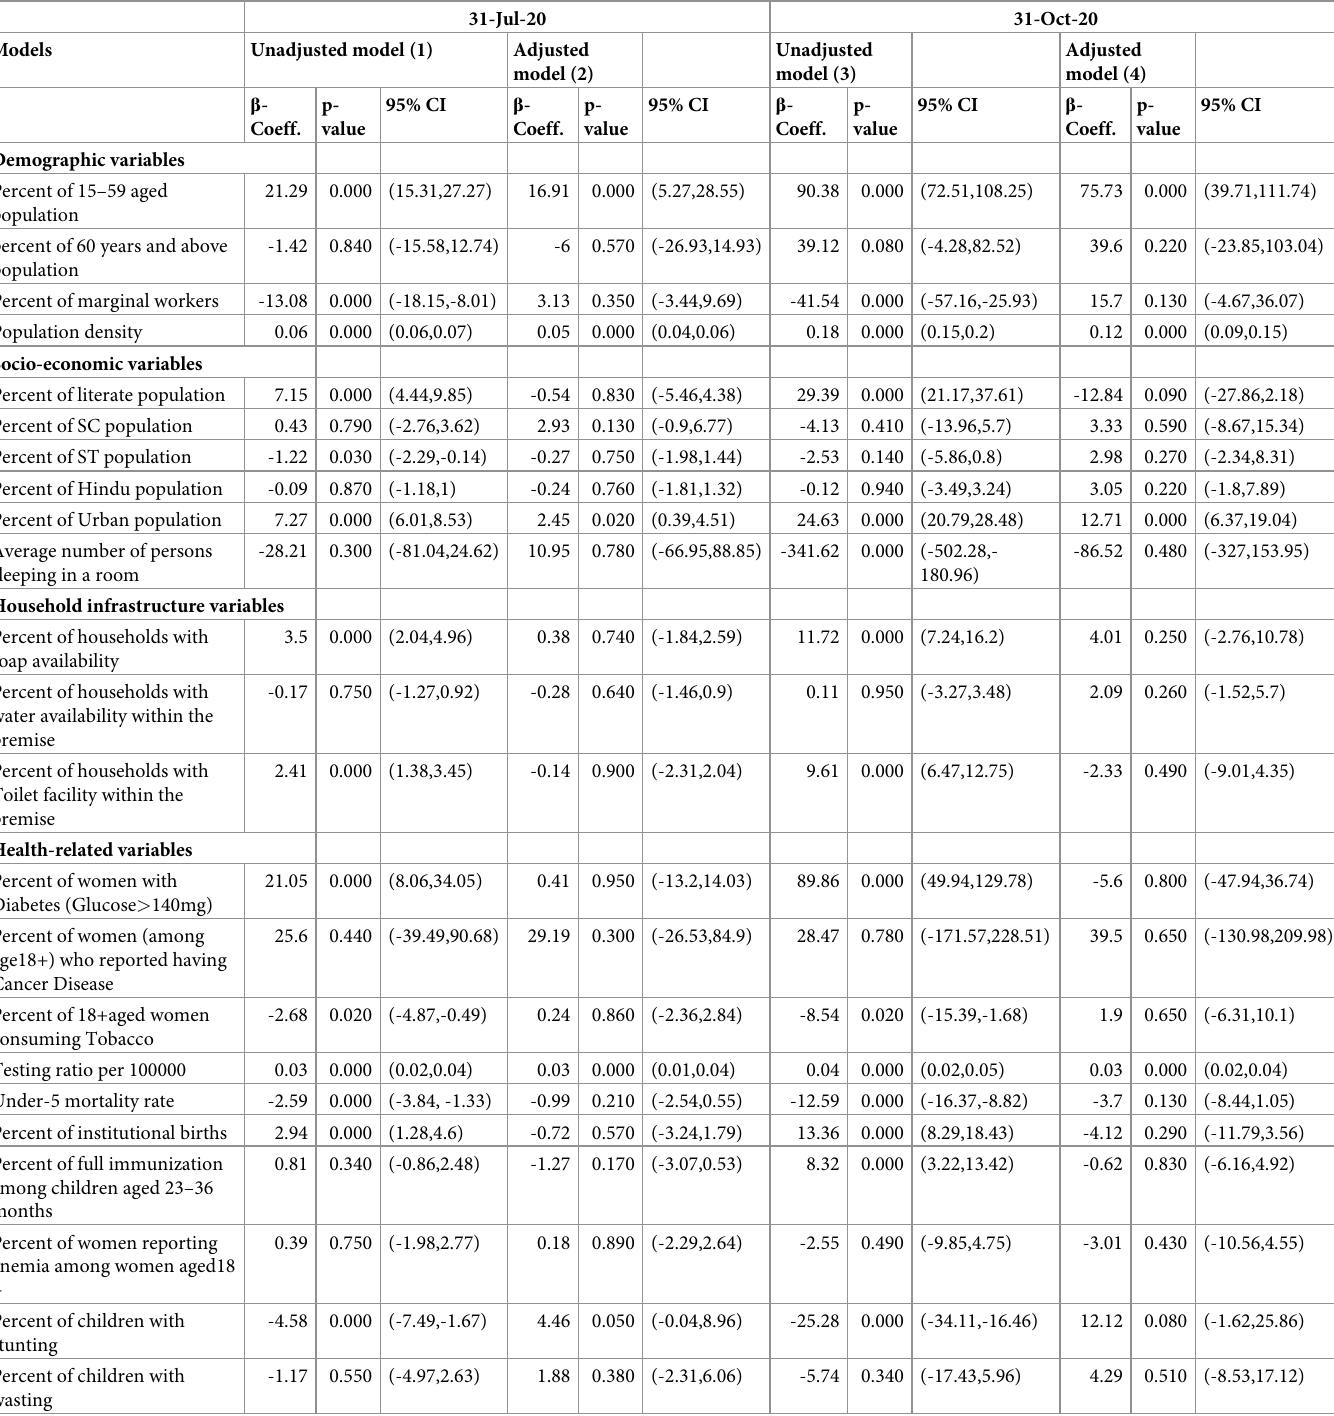
Table 2. Regression analysis of district correlates and infection ratio (IR) across 640 districts of India 1